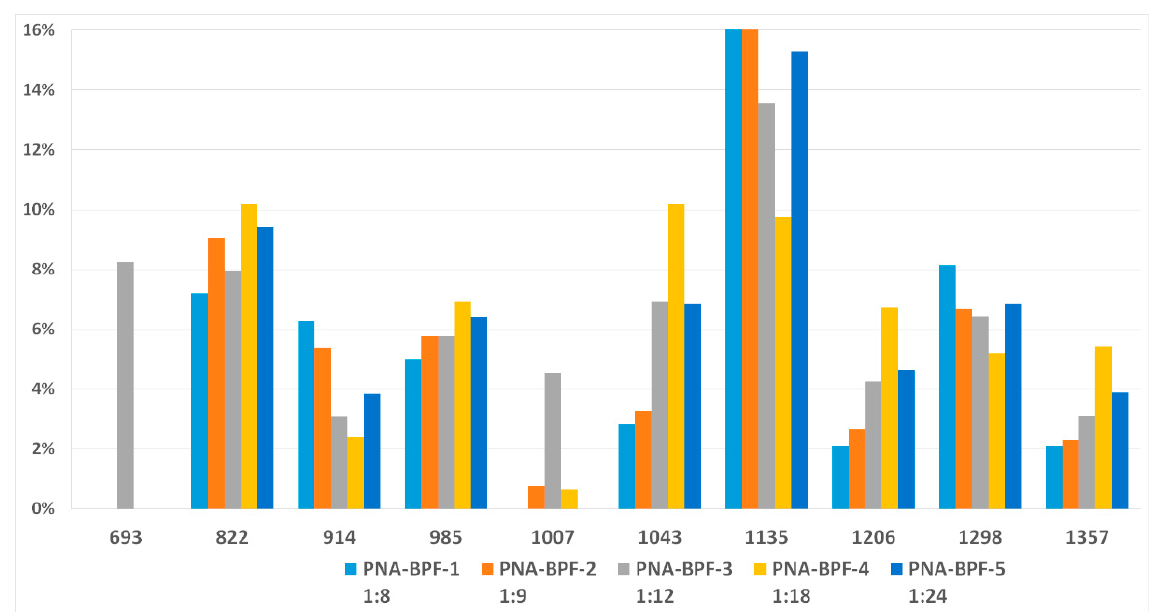
Figure 3. The content of compounds I–X (Table 2) in samples PNA-BPF-1 ÷ 5 ((1)–(5), respectively).